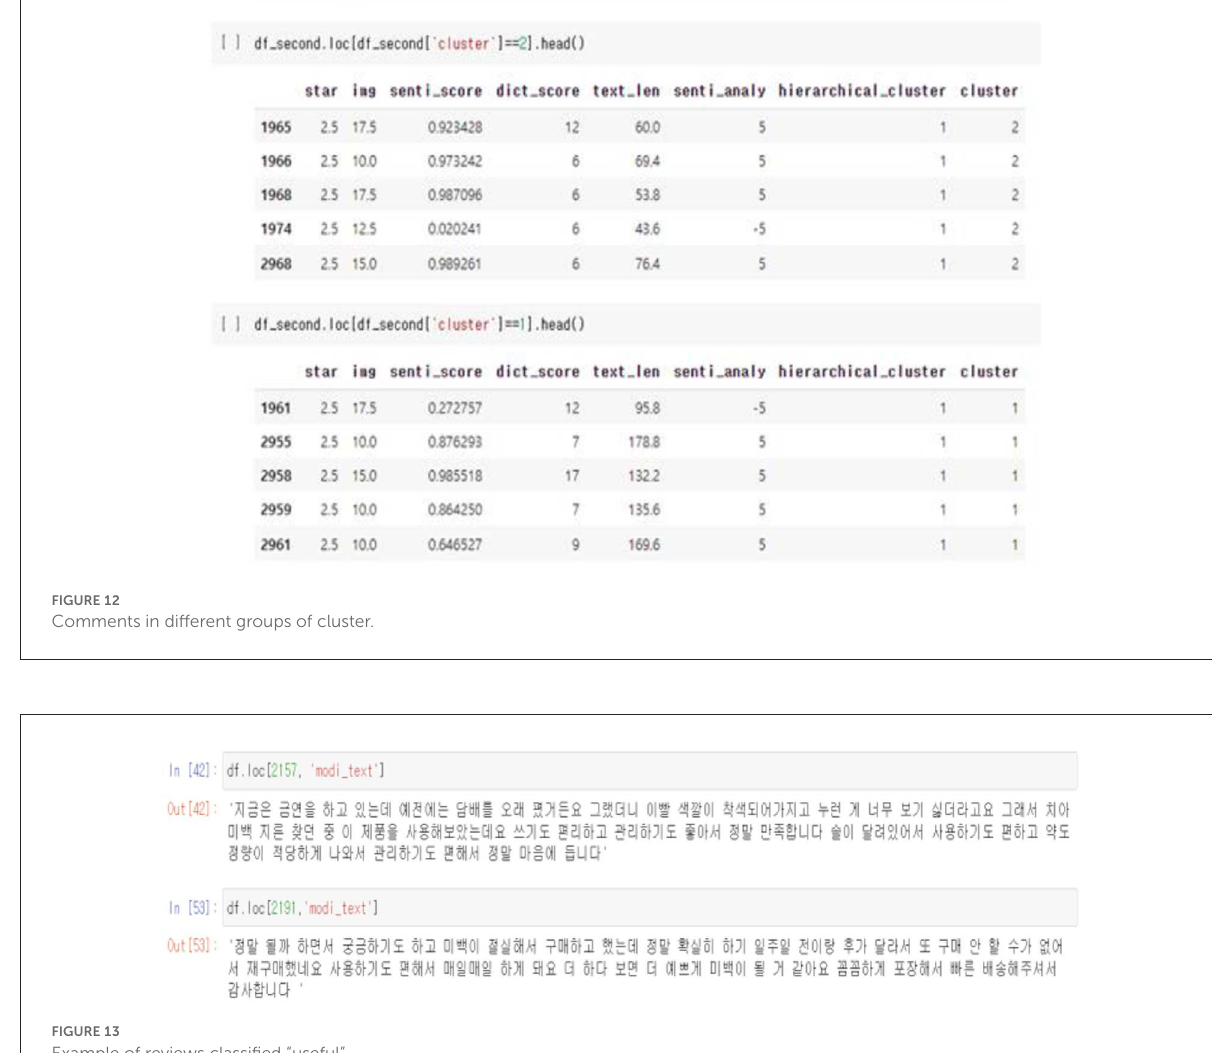
FIGURE13 Example of reviews classified